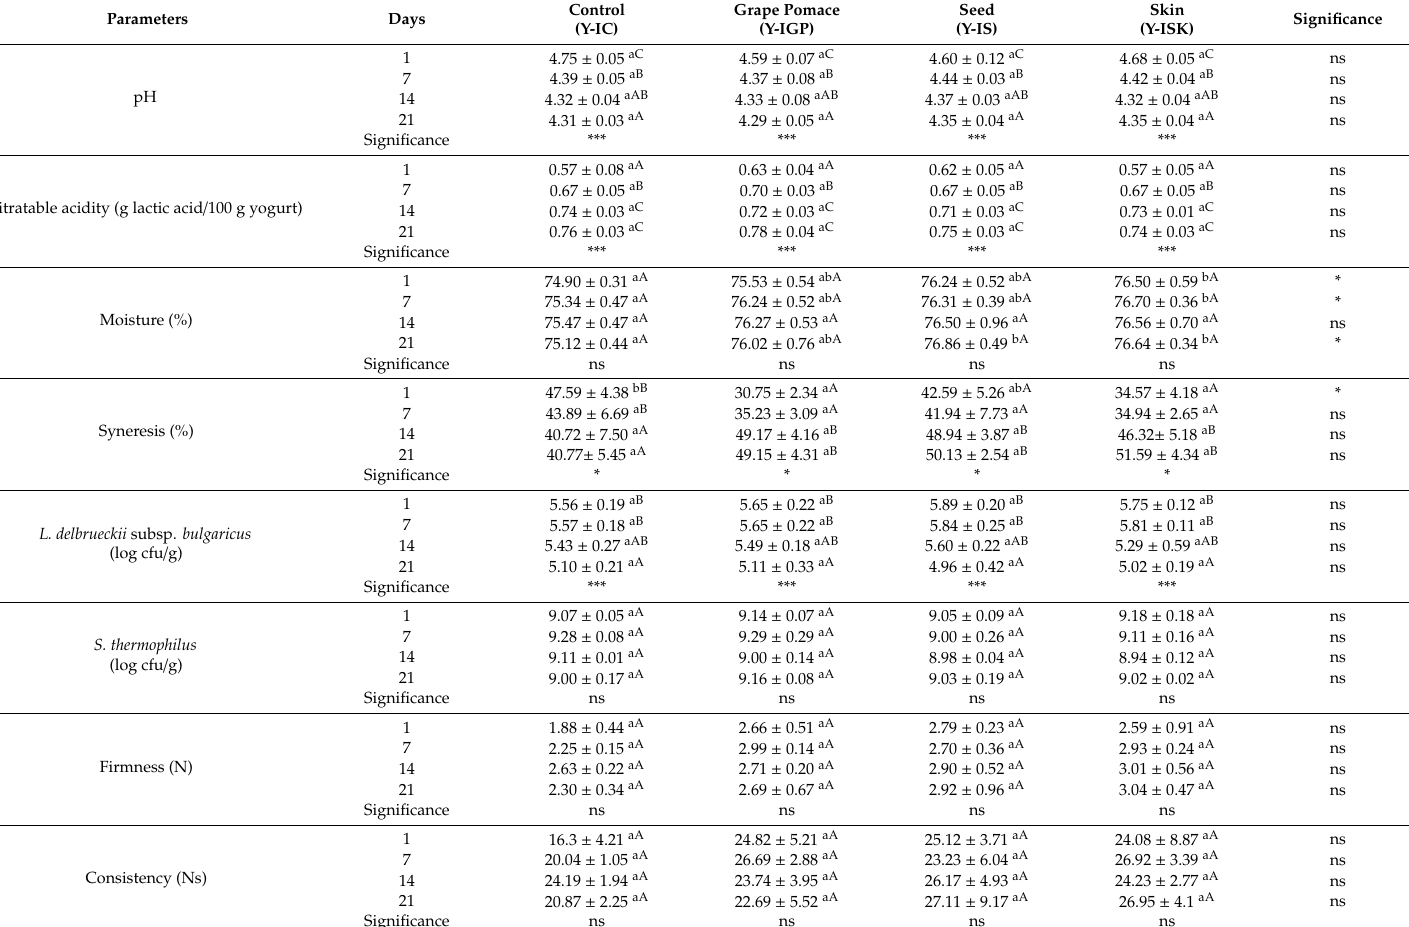
Table 4. Evaluation of the shelf-life stability of yogurts formulated with inulin-type fructans, together with grape pomace, seed and skin extracts, during 21 days of cold storage: physicochemical parameters, viability of starter bacteria and instrumental texture